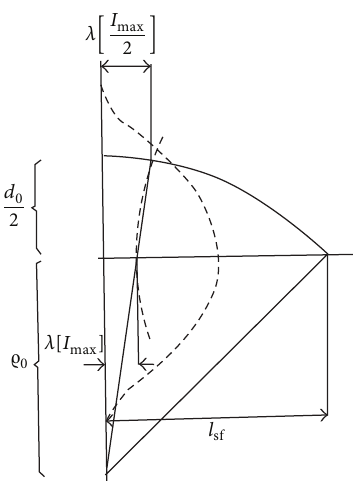
Figure 9: Relativistic self-focusing [26]: relativistic change of elec- tron mass results in shorter optical propagation at higher intensity thanatlowerintensity.Relativisticself-focusingofalaserbeamfrom the left with a dashed Gaussian intensity profile and radius 𝑑 𝑜 /2 moves into plasma right from the vertical line. Due to the relativistic change of the electron mass at the quiver motion, the effective wave length within the plasma is dielectrically shorter at higher intensity then at lower causing a concave bending of the initially plane wave front with shrinking of the beam to less than wave length diameter [26, 31,